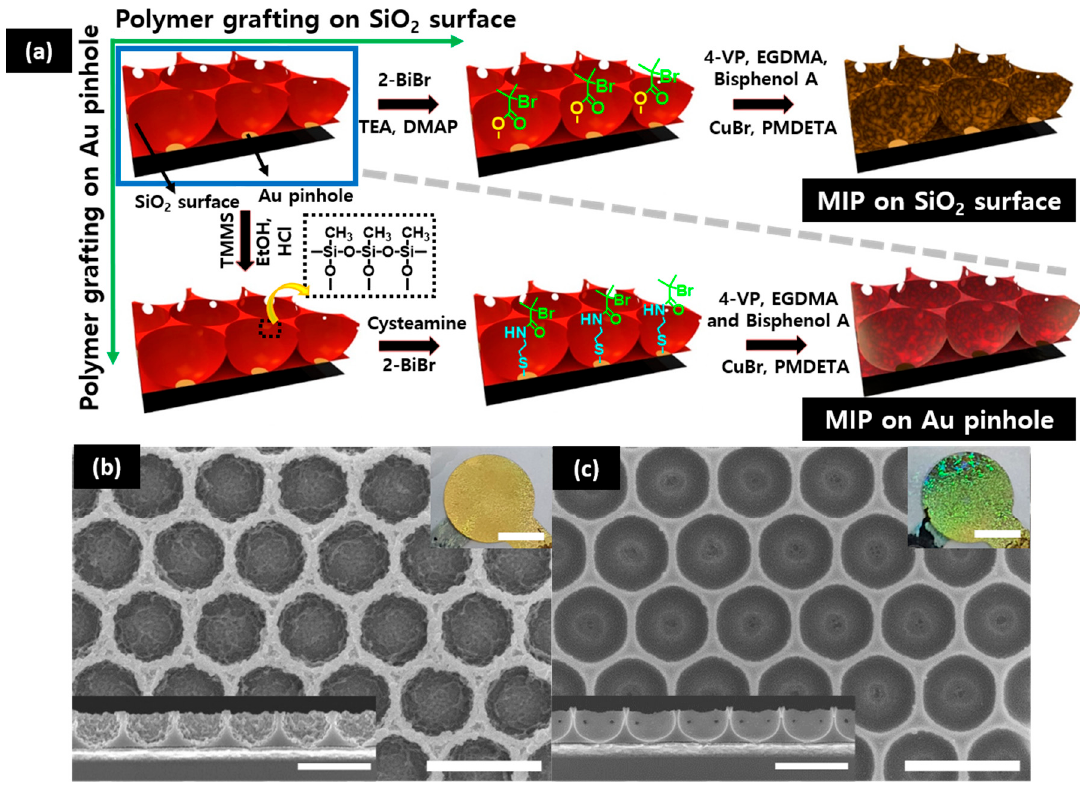
Figure 1. ( a ) The fabrication process of the s ‐ MIP film (grown from the only silica surface) and p ‐ MIP films (formed on the gold pinholes) on 2D porous silica thin films and ( b,c ) scanning electron microscopic (SEM) images of ( b ) s ‐ MIP film and ( c ) p ‐ MIP films. The insets represent the side views of the two MIP films (scale bars are 1 μ m) and the photographs of MIP ‐ based QCM sensors (scale